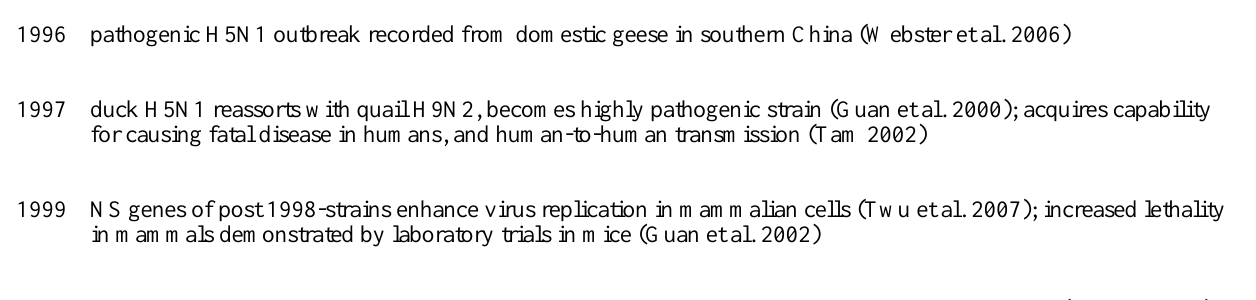
Table 1. Key observed changes in epidemiological characteristics of the H5N1 HPAI